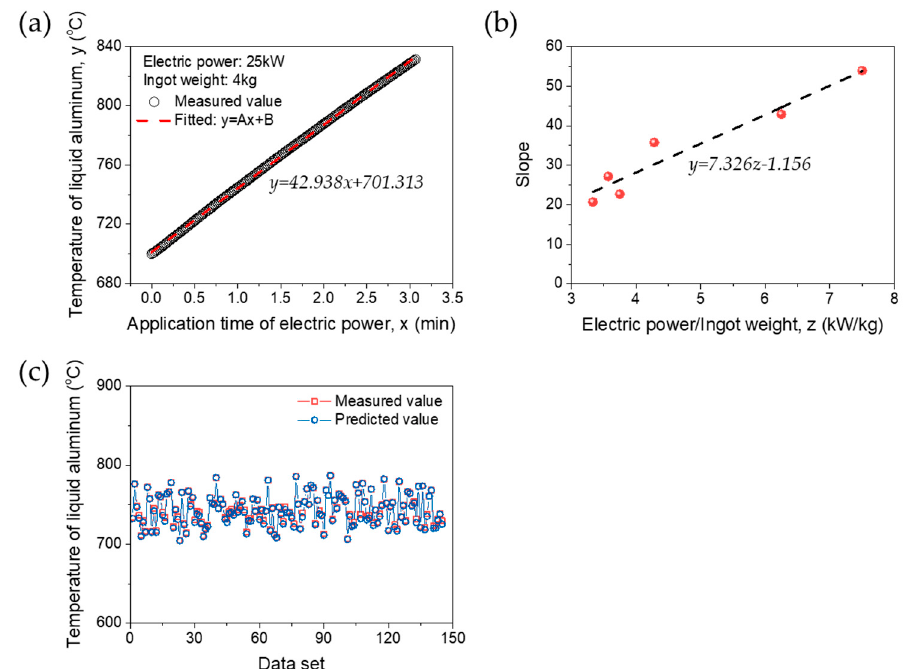
Figure 9. ( a ) Linear fitting of measured value (one example of experimental results: electric power 25 kW, ingot weight 4 kg), and ( b ) numerical approach via electric power / ingot weight. ( c ) The comparison of measured value by experiment versus predicted values by empirical model of melt temperature for validation.